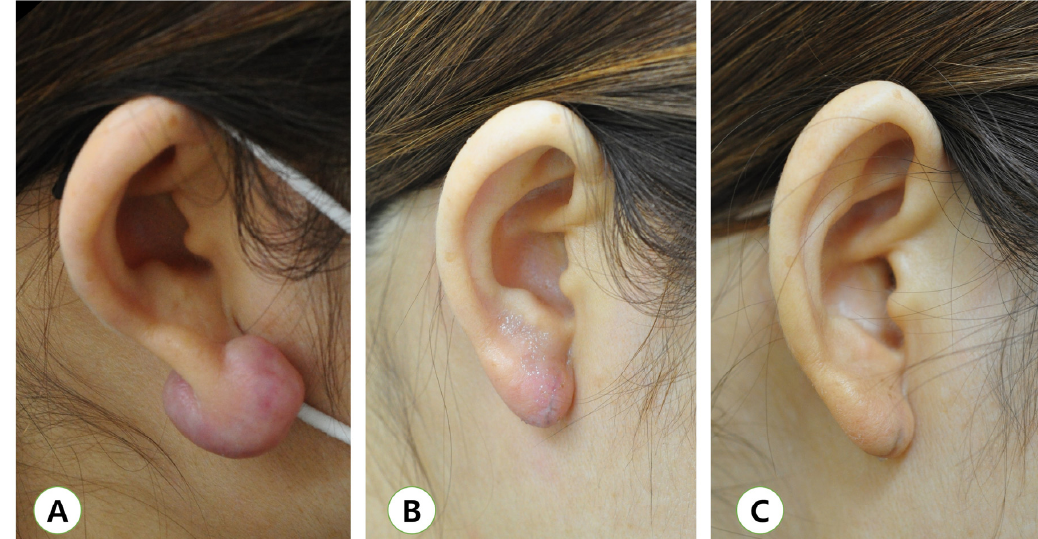
Figure 3. ( A ) Pre-operative view, ( B ) immediately post-radiotherapy (20 Gy in five fractions following excision of keloids). Radiotherapy was initiated within 24 h after the excision. No treatment-related complication was noted. ( C ) One-year follow-up image of following treatment with adjuvant radiotherapy. No recurrence of the elevation of the mass was noted. The same meta-analysis revealed the different recurrence rates by the site of keloid lesions. In respect of the site of keloid lesion, the lesions located on the chest and trunk had the highest recurrence rate of 34% compared with the lesions on the ear, head and neck, or extremities. Keloids localized on the ear were found to have the lowest rate of recurrence (12%) [27]. The difference in the tensile strength of the skin in each of these areas may cause this variation in recurrence rates by the site of lesions. 7. Complications after Radiotherapy In general, the application of relatively low total radiation doses does not stimulate skin and soft tissue reactions beyond the common toxicity criteria (CTC) level of Grade 1– 2 [17]. Acute and late complications are generally minor, and the most common side ef- fects are skin damage such as erythema, desquamation, and pigmentation. These were observed in 25% of cases reported in existing literature and were seen when higher total radiation dose was used [47,48]. An analysis of 194 patients with keloids reported that the incidence of moderate-to-severe skin reactions (hyperpigmentation, depigmentation, and telangiectasis) was 19%, but none of the patients had critical complications of CTC grade 3 or higher [13]. Other studies have demonstrated very low incidence rates of less than 1% or no incidence rate for serious complications with wound infection or dehiscence [27,34,49]. To improve and accelerate the skin regeneration process, the patient should be instructed to apply hydrating products, such as aloe vera gel or glycerol, locally over the lesion for a few weeks after the post-surgical dressing has been removed. There is concern about the risk of secondary malignancies due to radiation exposure. After radiotherapy of keloid, the main risk to be considered is the induction of malignant disease by the radiation exposure of critical organs in the field and from scatter. Ogawa et al. found five cases recorded as radiation-induced malignant tumors in keloid patients [24]. However, the relationship with radiotherapy was ambiguous in most of them. Thus, they concluded that the risk of radiation-induced secondary malignancy is very slight. Other authors have stated no association between secondary malignancy and the use of radiotherapy in keloids [13,25,27,36,48]. Although the safety of the radiotherapy in keloid